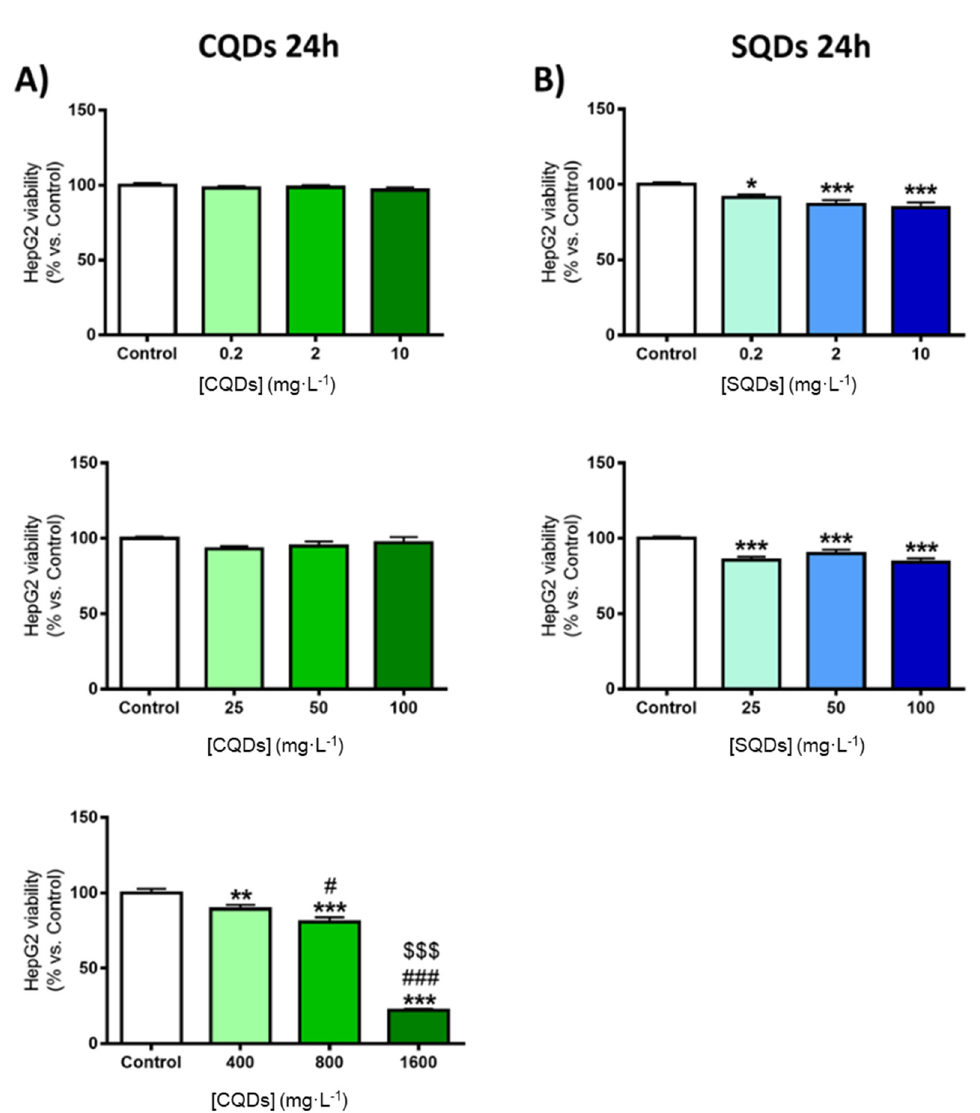
Figure 7. Cell viability data in carcinoma human hepatocellular cells (HepG2) cells cultured in the presence of 10% FBS and exposed to CQDs ( A ) and SQDs ( B ) at concentrations ranging from 0–1600 mg · L − 1 for 24 h. Control cells were cultured in medium (DMEM) alone. Cell viability was measured by the MTT assay. Data (mean ± SEM of at least three independent experiments with three replicate wells per treatment) were analyzed by one-way ANOVA multiple comparison test followed by Fisher’s LSD test. Significant differences are indicated as * p < 0.05, ** p < 0.01, *** p < 0.001 vs. control; # p <0.05, ### p < 0.001 vs. 400 mg·L − 1 ; $$$ p < 0.001 vs. 800 mg·L − 1 .